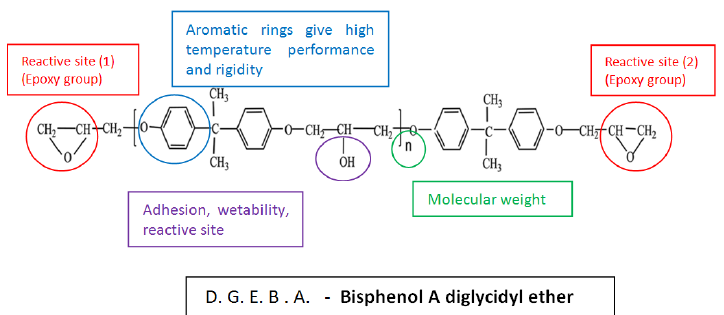
Figure 7. D.G.E.B.A. has two epoxy groups which can react with hardener and can initiate molecular chains. “n” is the repeat units and has an average value of n = 0.1 when there is no advancement in the polymerization. The aromatic group provides temperature improvement. Insulation needs such improvement and without advancement, a warm resin is liquid and can be processed for vacuum pressure impregnation (VPI).